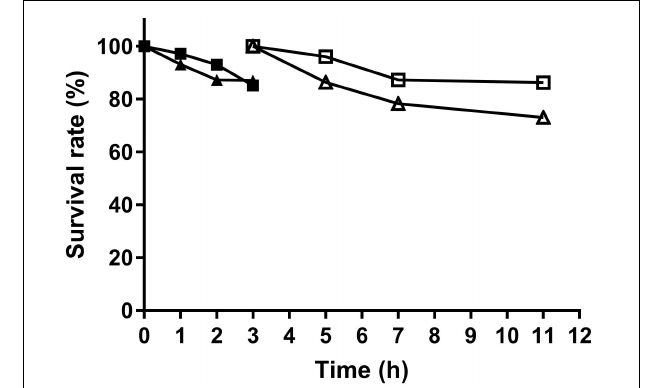
FIGURE 5 | Survival of L. fermentum in gastric and intestinal juice. (cid:4) NCU3087 in gastric juice, (cid:77) NCU3087 in intestinal juice, (cid:78) NCU3088 in gastric juice, (cid:77) NCU3088 in intestinal juice. The experiments were performed in triplicate, and the data are mean ± SD.